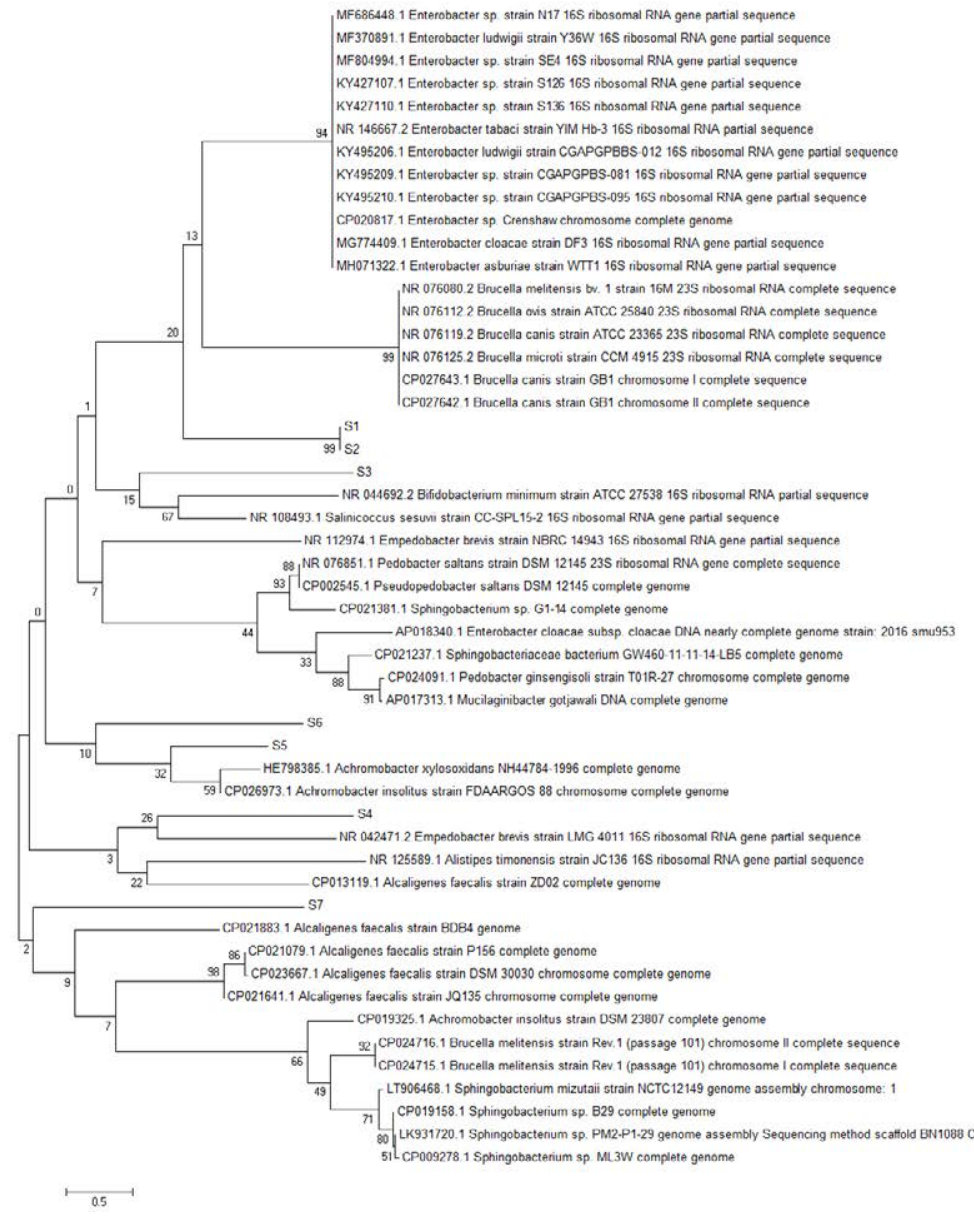
Fig. 3. Reconstruction of the phylogeny tree with minimum evolution model. The phylogeny tree construction uses two models with 1000x boostrap with MEGA